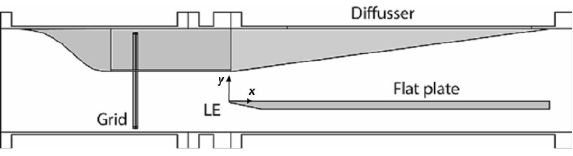
Fig. .1 Experimental setup - flat plate with diffusser along the model of flat plate in a test